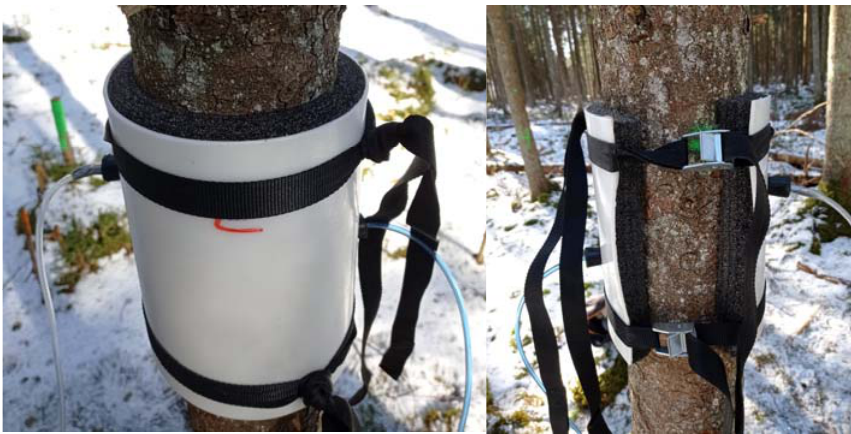
Figure 3. Gas measurement chamber on a tree stem in the study area.